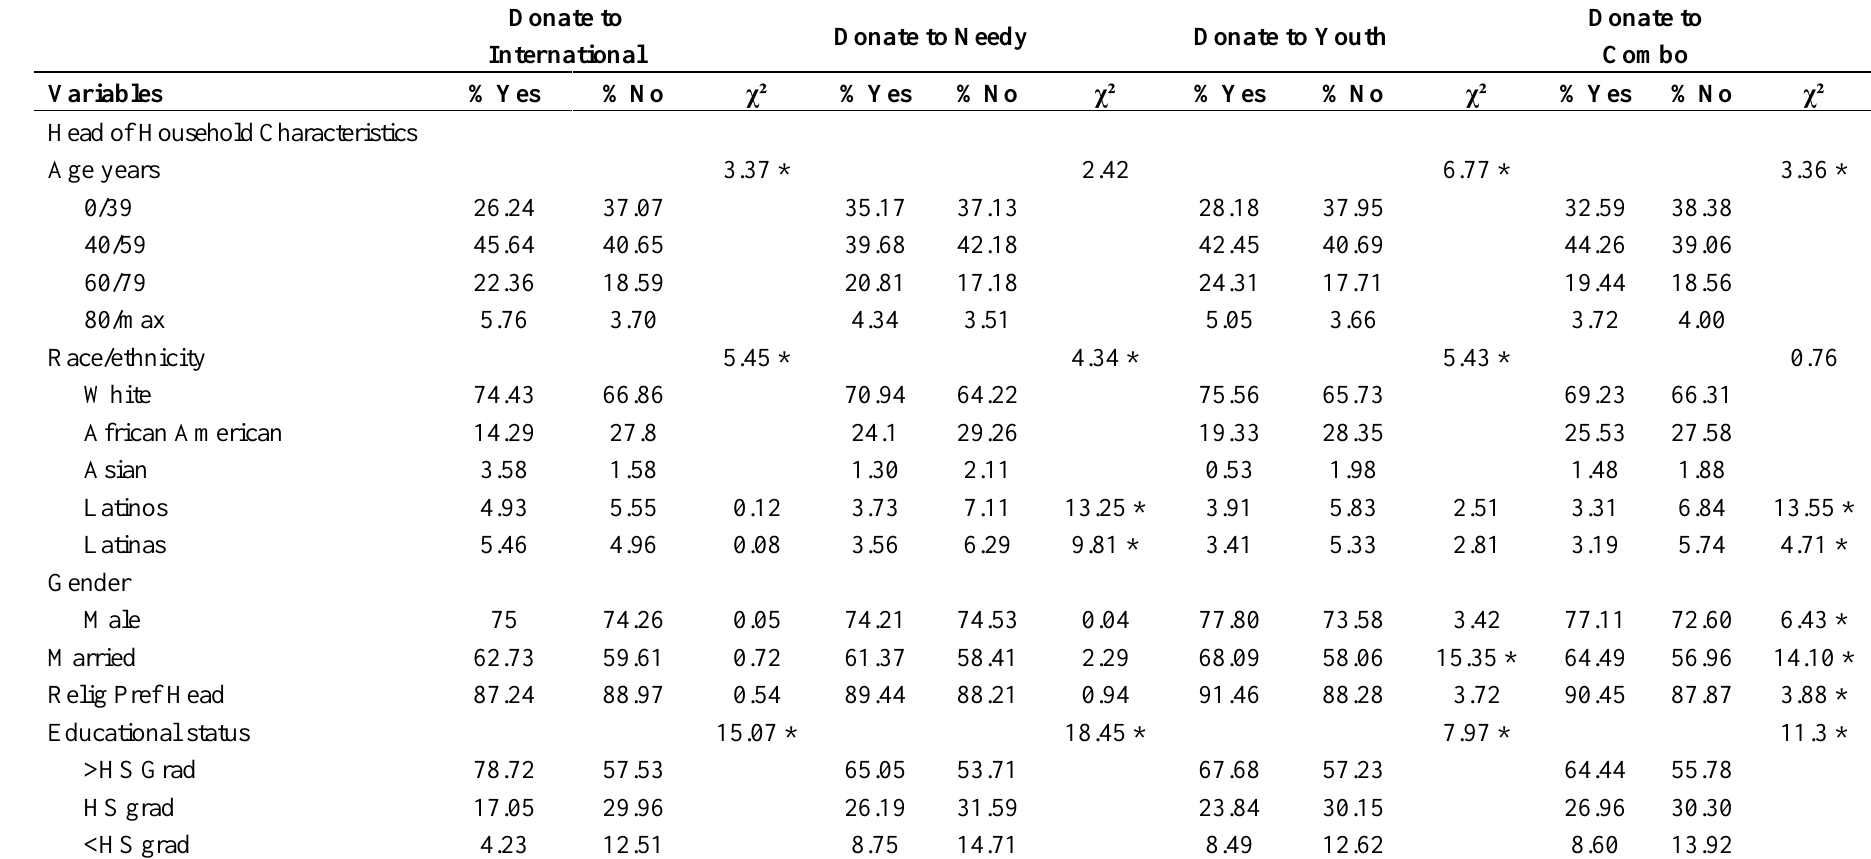
Table 4. Bivariate analysis of independent variables association with charitable organizations